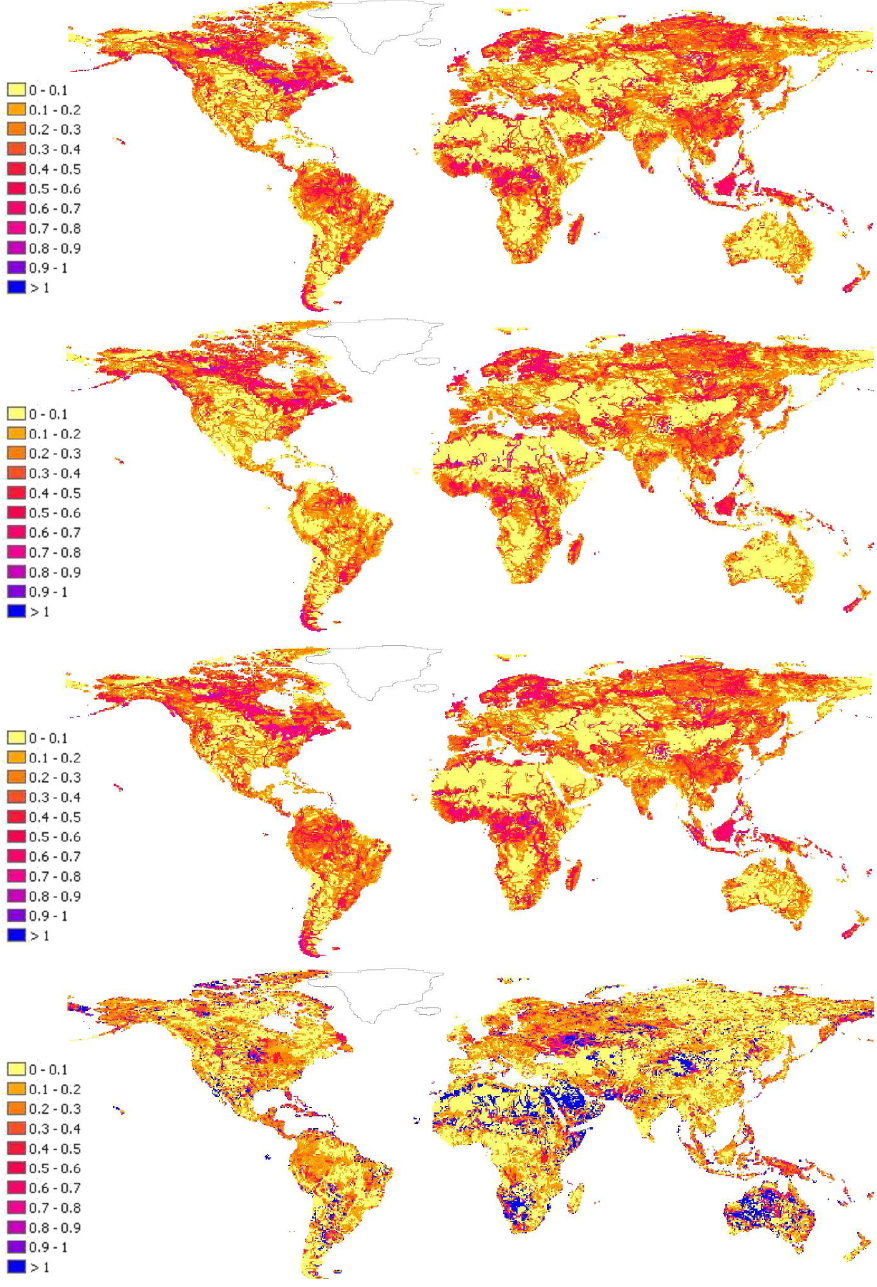
Figure 11: Thirty year average relative Q10 values: Q 10 / Q (-) calculated from a) the PCR-2 Fig. 11. Thirty year average relative Q10 values: Q 10 /Q (–) calculated from (a) the PCR-GLOBWB run forced with the ERA6190 dataset, (b) the PCR-GLOBWB run forced with the ERACLM dataset, (c) the ensemble mean discharge results of the 12 GCM based PCR-GLOBWB GLOBWB run forced with the ERA6190 dataset, b) the PCR-GLOBWB run forced with the3 runs and (d) the CV (–) of the thirty year average Q10 of the ensemble of GCMs. ERACLM dataset, c) the ensemble mean discharge results of the 12 GCM based PCR-4 GLOBWB runs and d) the CV (-) of the thirty year average Q 10 of the ensemble of GCMs.5 14 out of 19 basins. Differences between the runs in both relative Q10 and relative Q90 are largest for Amazon and